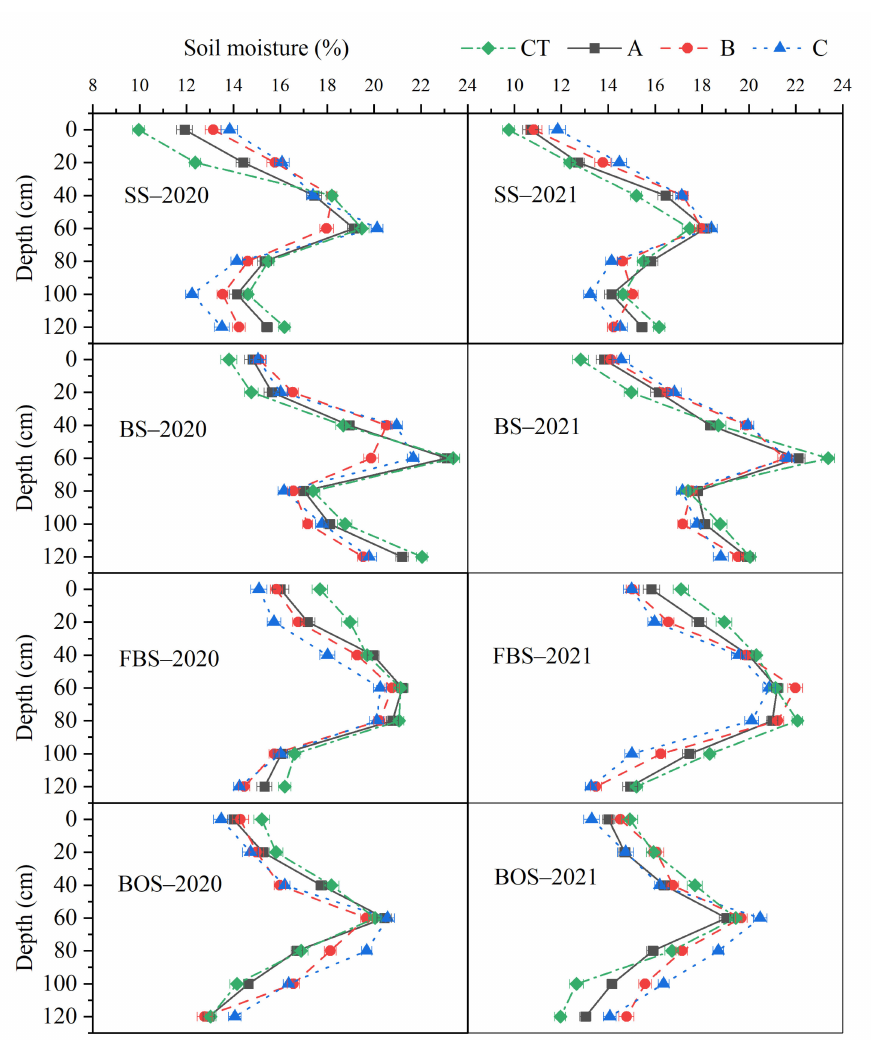
Figure 4. Comparison of the vertical distribution of soil moisture under different smashing ridge tillage depth treatments during the growth periods in 2020 and 2021. Data (mean ± SD) were collected from soil depths between 0 and 120 cm. CT, conventional tillage; A, 20 cm; B, 40 cm; C, 60 cm. SS, seedling stage; BS, bud stage; FBS, flowering and boll stage; BOS, boll opening